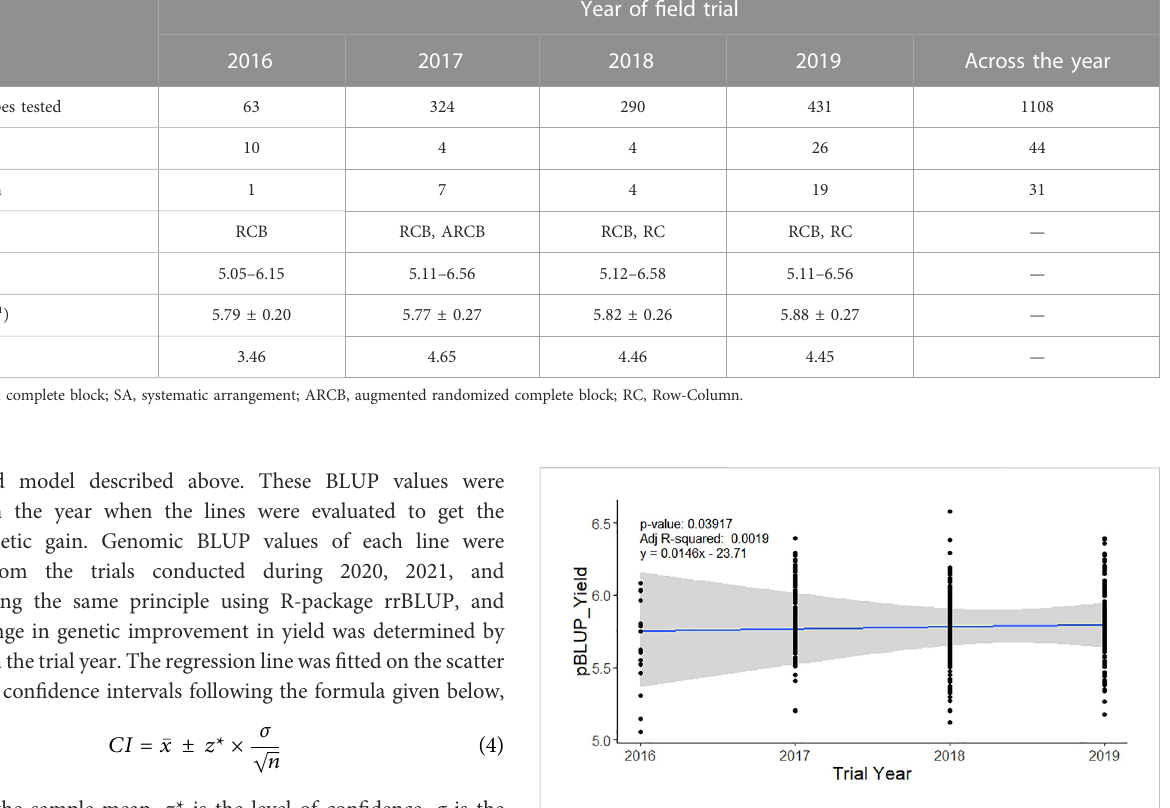
FIGURE 2 Baseline genetic gain for yield in the irrigated breeding program of BRRI during 2016 – 2019. Performance BLUP for the yield of each line was regressed over the year of the trial to extract the rate of genetic improvement per